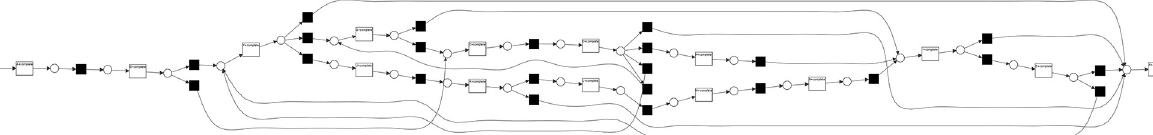
Fig 11. Result model from heuristic miner.